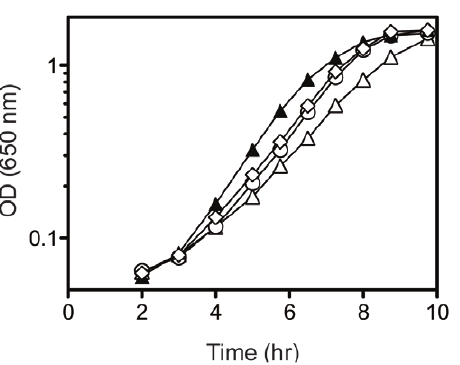
Figure 3. Suppressor mutations increase growth in purFridA strain background. Strains were grown at 37 u C in minimal glucose medium with adenine (open symbols) or further supplemented with 0.3 mM threonine (closed symbols). Growth was monitored over time as optical density at 650 nm. Shown are strains purF ridA (DM3871), triangles; purF ridA thrA1371 (DM6309), diamonds; and purF ridA dapA356 (DM11412), circles. Error bars represent standard deviations of three biological